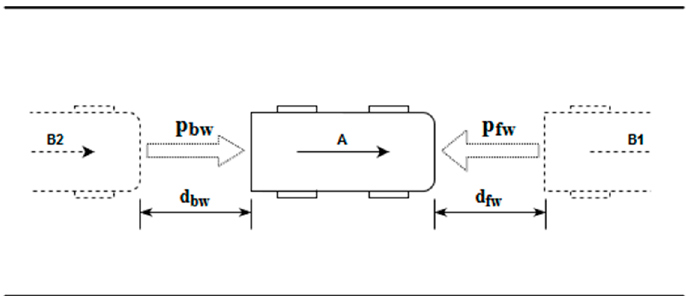
Figure 2. Scheme for the forward and backward potential fields calculation.